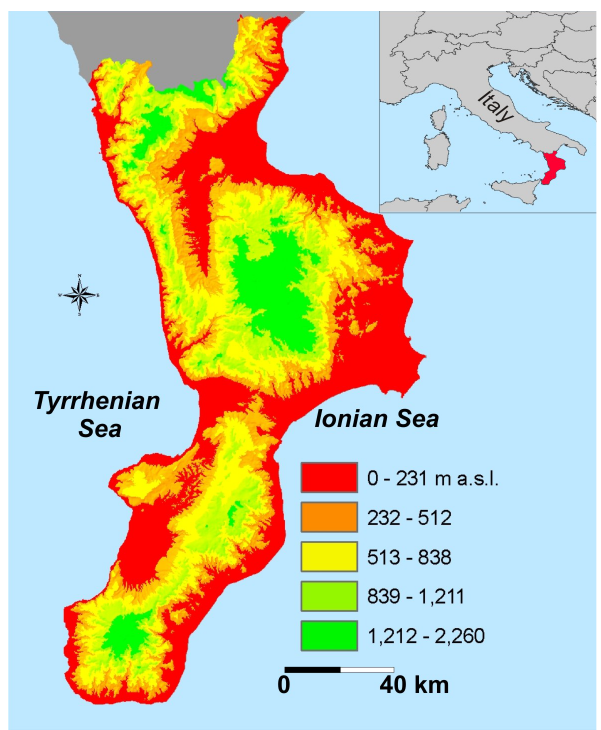
Fig. 1. Digital elevation model of the Calabria region and its loca- tion on the Italian